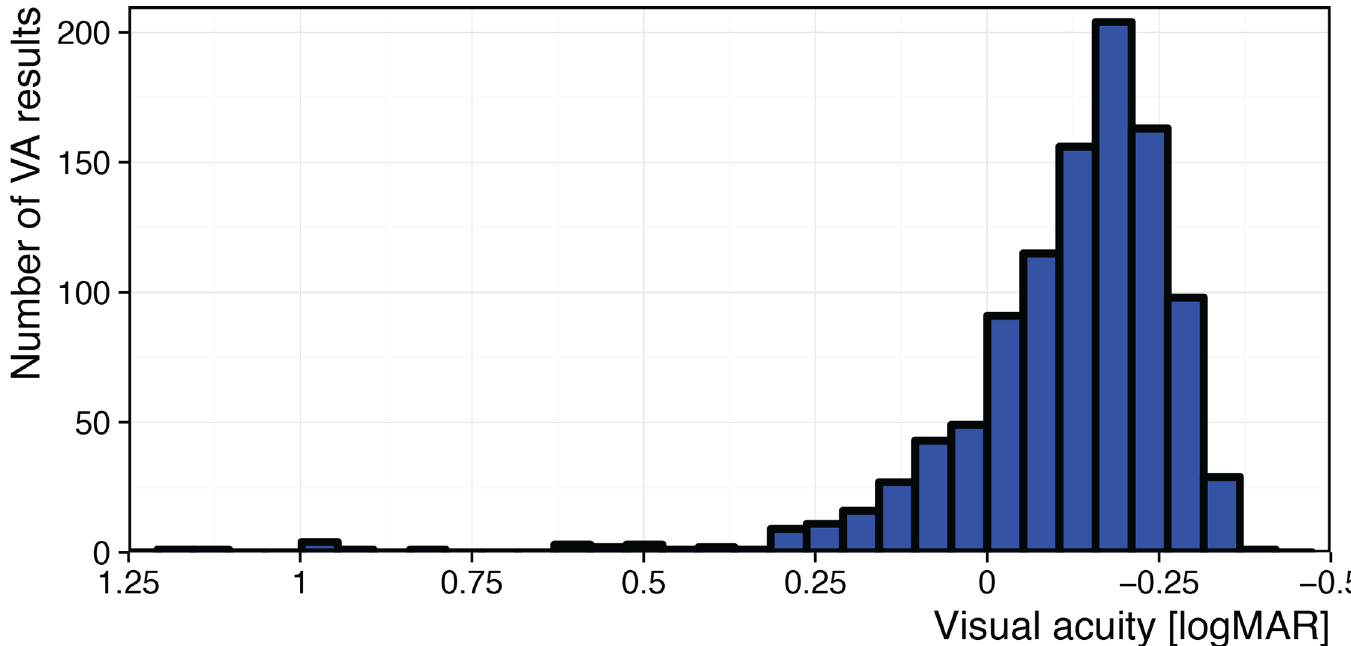
Fig 1. Distribution of visual acuities for all participants, eyes, test conditions and repeats; better acuity is to the right. Most acuities are in the normal range, with a few outliers. The poorest acuities ( > 0.75 logMAR) are all from a single eye in one participant.